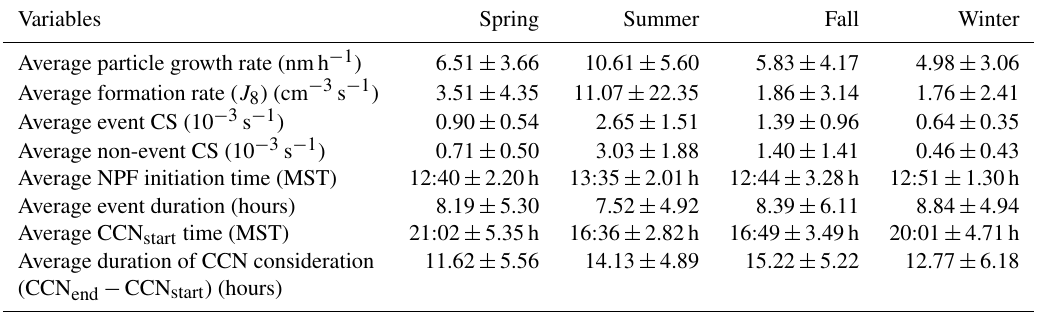
Table 2. Seasonal summary of variables calculated for type 1a and 1b events. Values are presented as the mean of the variable ± 1 standard deviation.